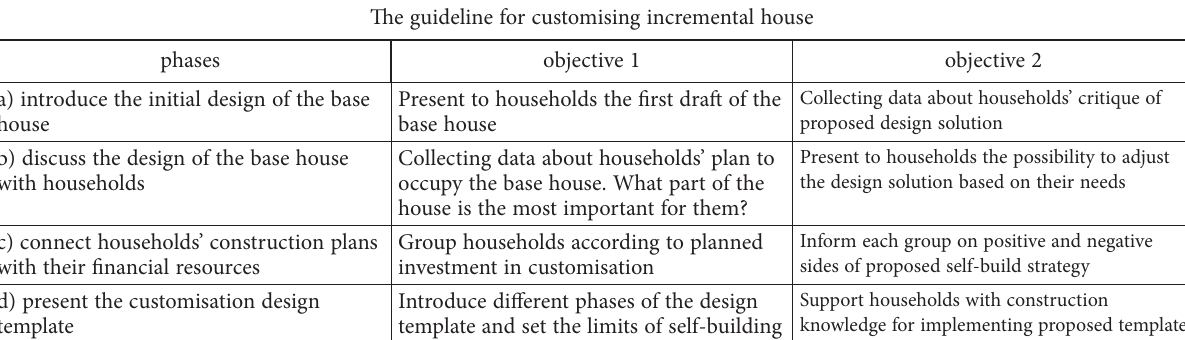
Table 1. Structure of the guideline for customising incremental housing (source: the